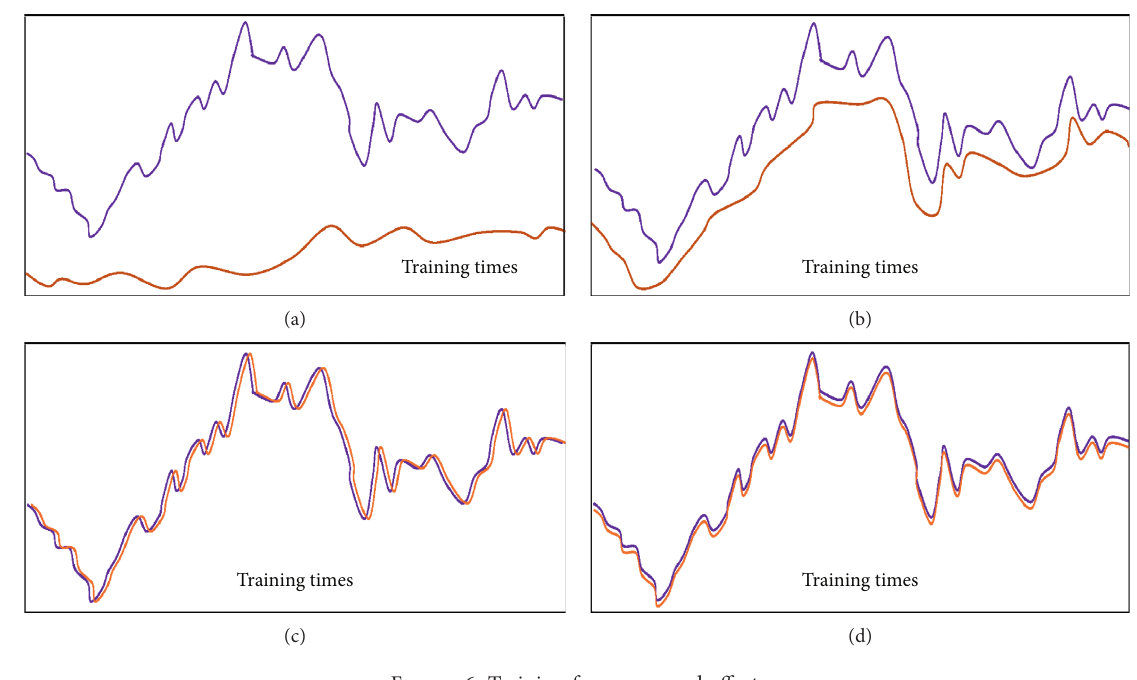
Figure 6: Training frequency and effect. Table 1: LSTM network prediction